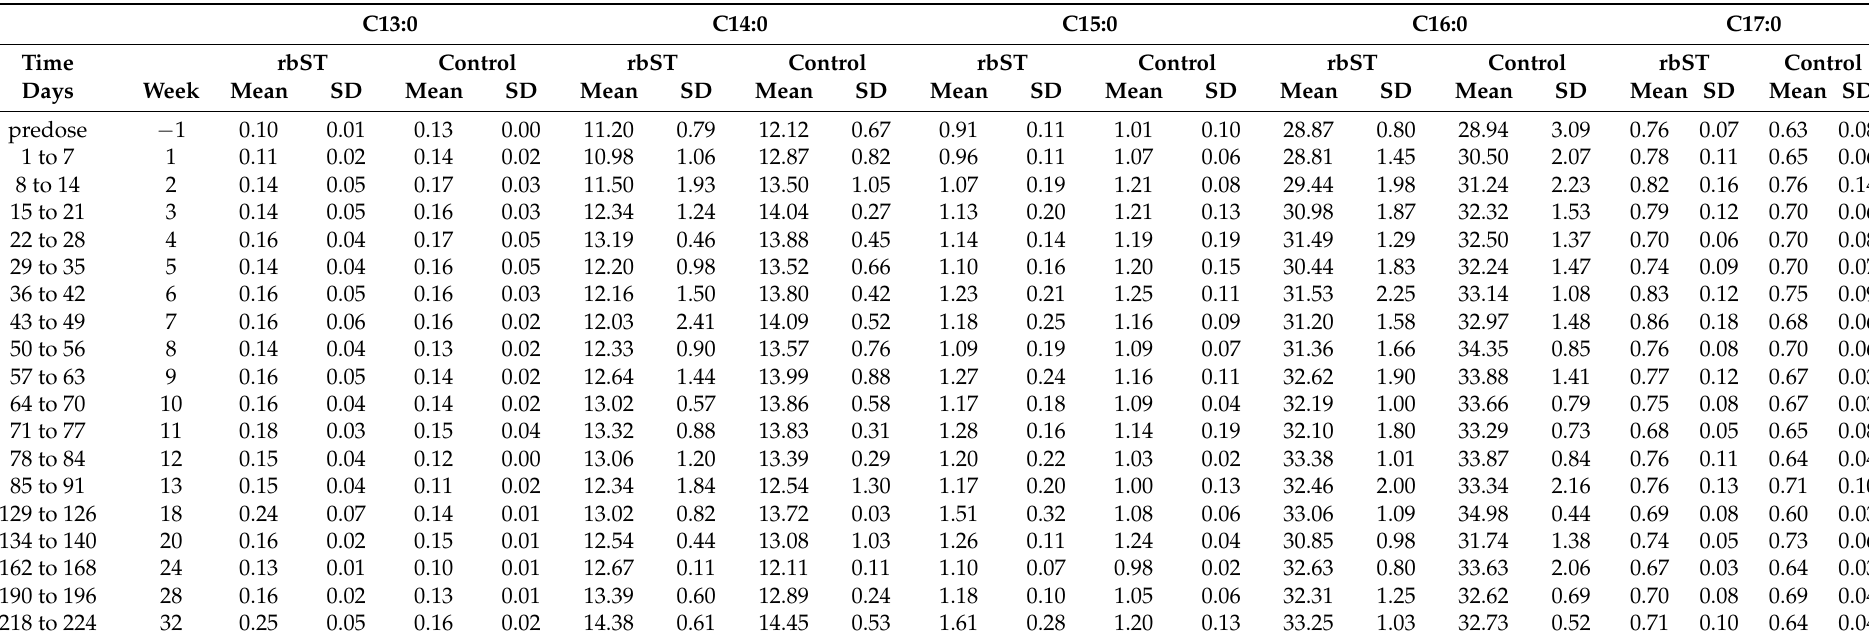
Table 2. Long-chain saturated fatty acids (up to 17 carbons) in milk (% w / w of total fatty acids) obtained from cows treated with recombinant bovine somatotropin (rbST) ( n = 6) and from control animals ( n = 3) at different time points selected over the course of 37 weeks (8 injections of Lactotropina manufactured by Elanco, Eli Lilly,